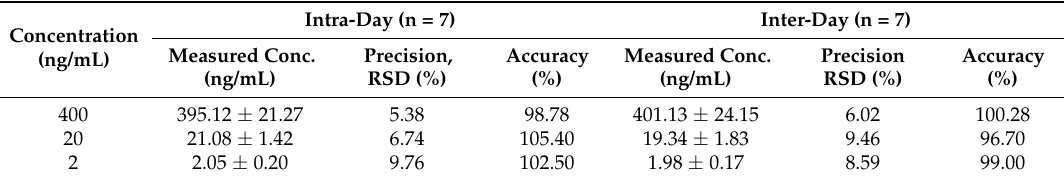
Table 1. Intra- and inter-day precision and accuracy of osimertinib in rat plasma. RSD: relative standard deviation.